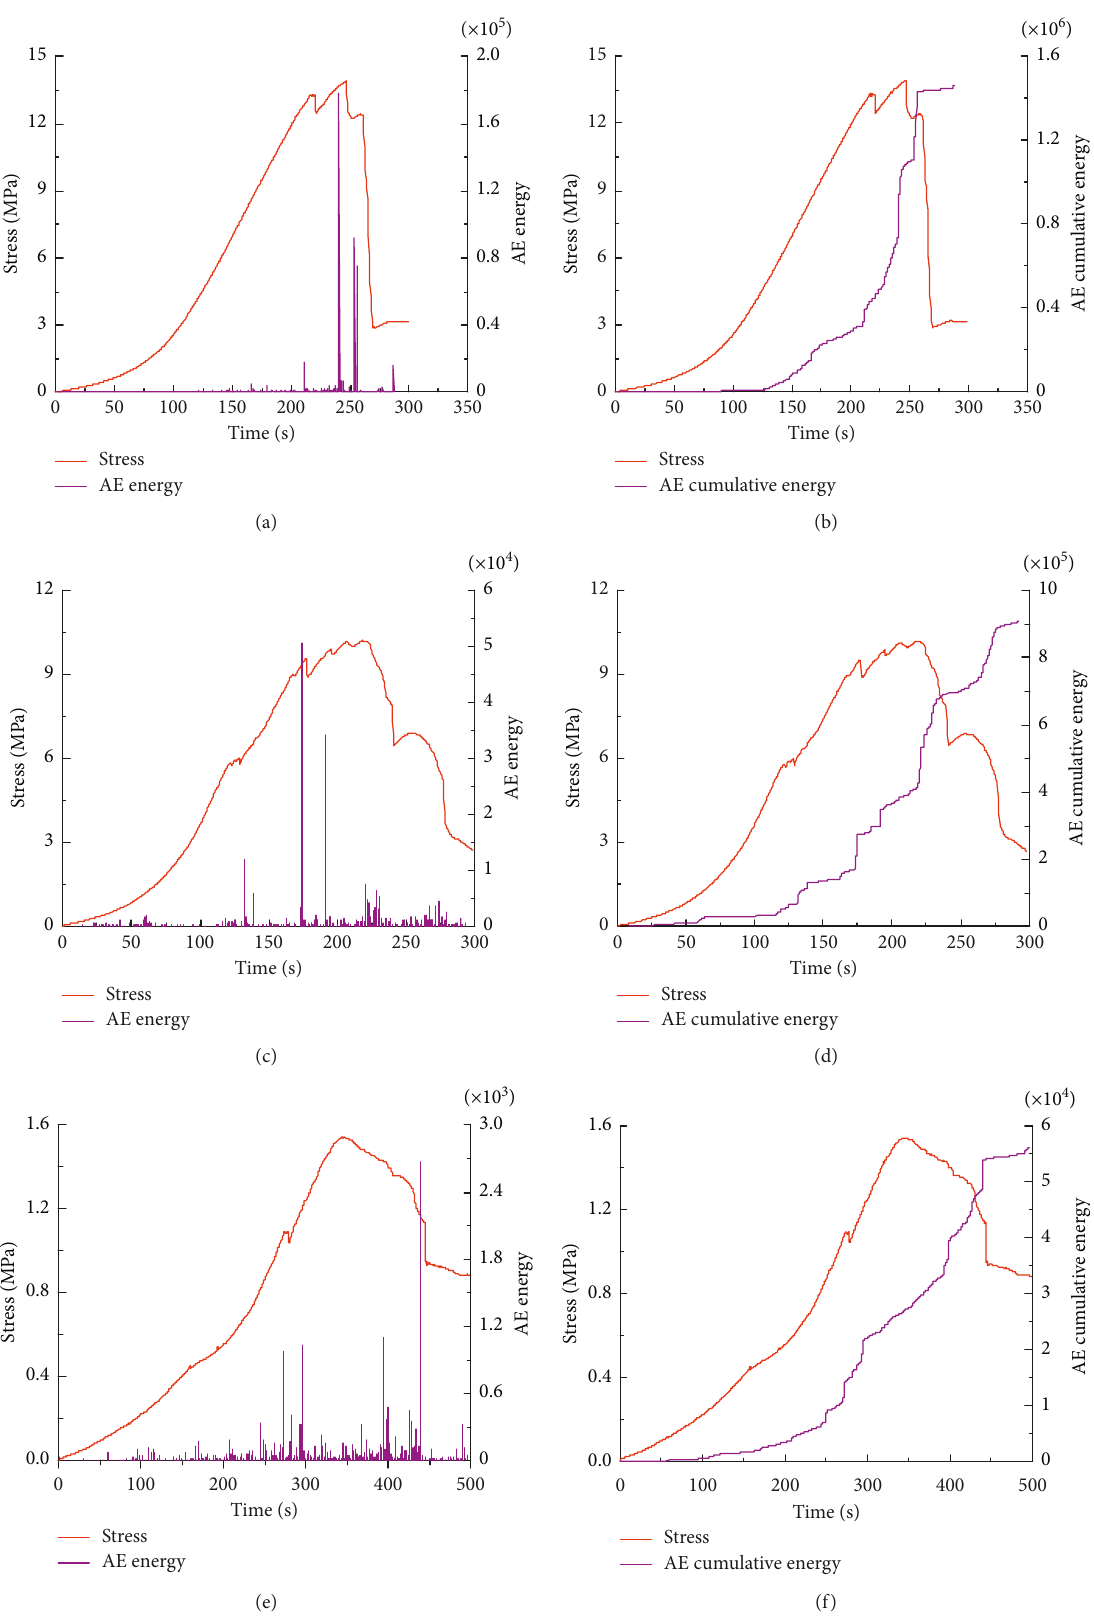
Figure 9: Variations of AE energy and cumulative energy with time of natural, naturally saturated and forcedly saturated coal samples. (a) Natural coal sample A8. (b) Natural coal sample A8. (c) Naturally coal sample B7. (d) Naturally coal sample B7. (e) Forcedly saturated coal sample C6. (f) Forcedly saturated coal sample